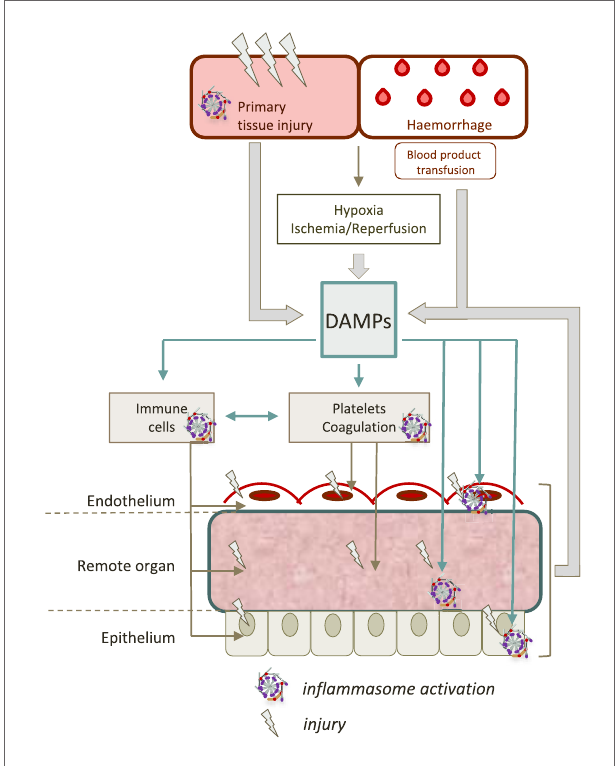
FiGURe 2 | Contribution of inflammasomes to remote tissue damage after trauma. The initial trauma injury induces the release of a large amount of different damage-associated molecular patterns (DAMPs). DAMPs can activate inflammasomes in various cell types such as hematopoietic cells (platelets, neutrophils, monocytes, and macrophages), epithelial cells, or endothelial cells. This dramatic inflammasome activation leads to increase the release of new DAMPs, maintaining a vicious circle, that contributes to worsen organ damage and propagate the pro-inflammatory